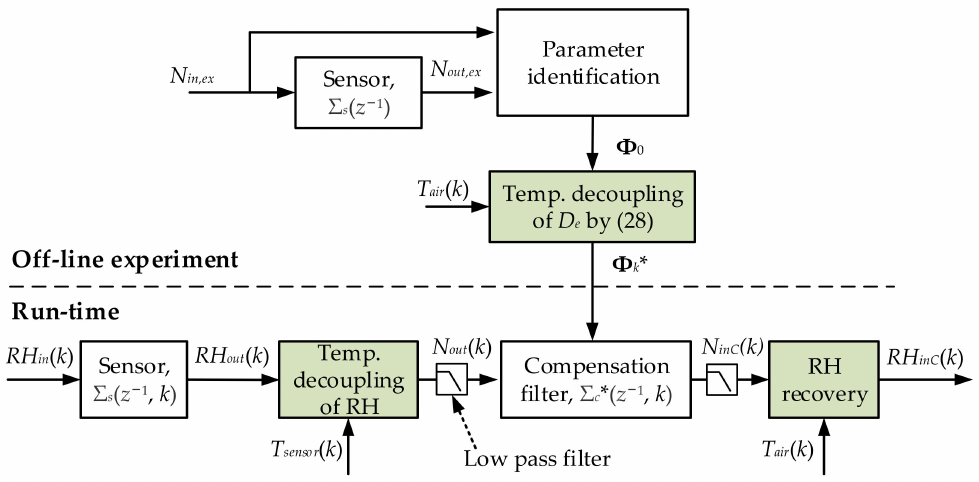
Figure 6. Dynamic compensation process for humidity sensors based on temperature